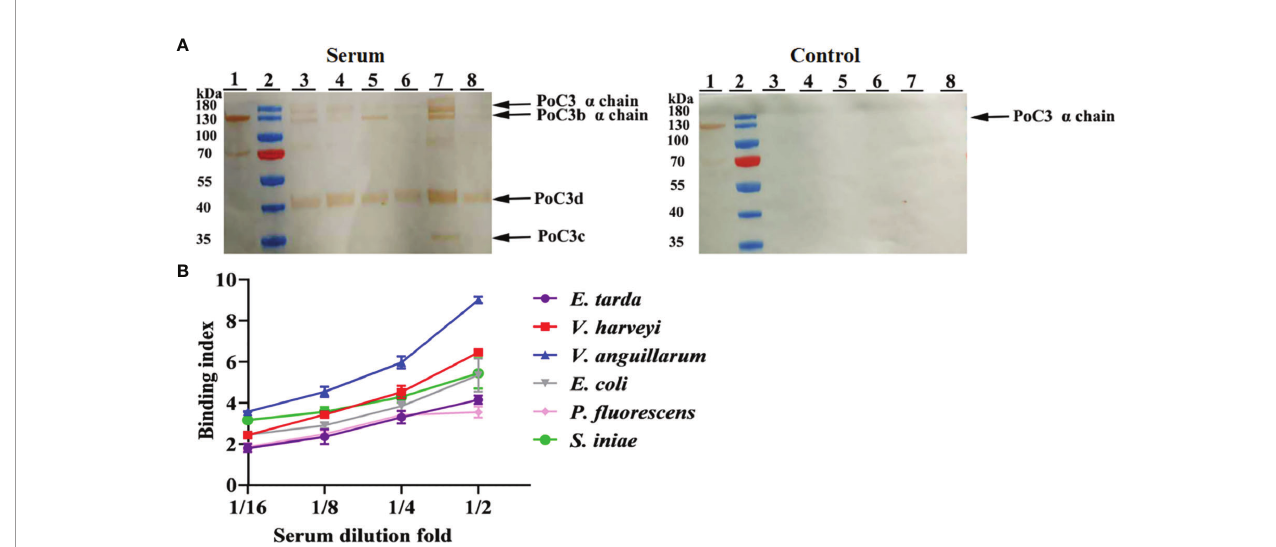
FIGURE 4 | Serum PoC3 binding to bacteria. (A) Different bacteria were incubated with or without (control) serum for 1 h, and Western blot was performed to detect bacteria-bound serum C3 with mouse anti-PoC3 polyclonal antibody. Lane 1, Japanese fl ounder serum. Lane 2, protein marker. Lane 3 to 8 are Vibrio harveyi, Edwardsiella tarda, Escherichia coli, Streptococcus iniae, Vibrio anguillarum and Pseudomonas fl uorescens . (B) Different bacteria were incubated with or without different dilutions fold Japanese fl ounder serum, and PoC3 in serum interacted with bacteria was determined by ELISA. Data are the means of three independent assays and presented as means ± SEM.